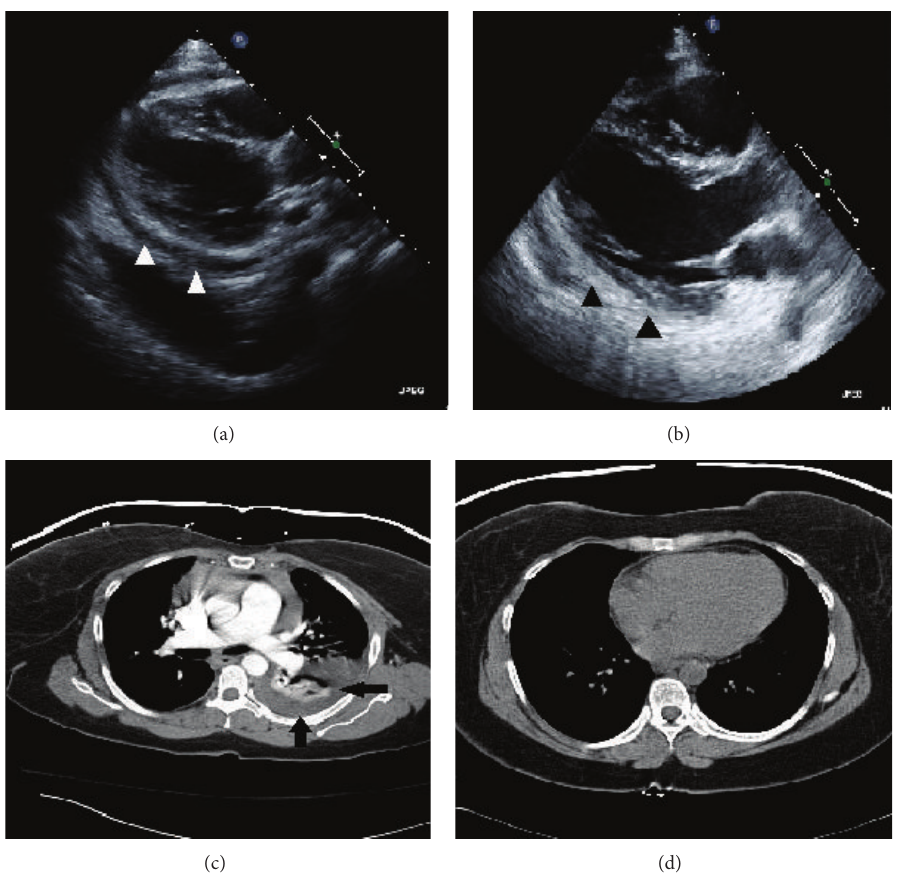
Figure 1: (a) Demonstrating pericardial effusion seen on echocardiogram, with (c) showing a large pleural effusion seen on computerized tomography. Both scans were obtained at second presentation in 2013. ((b) and (d)) Demonstrating complete resolution of both effusions at 3-month follow-up.